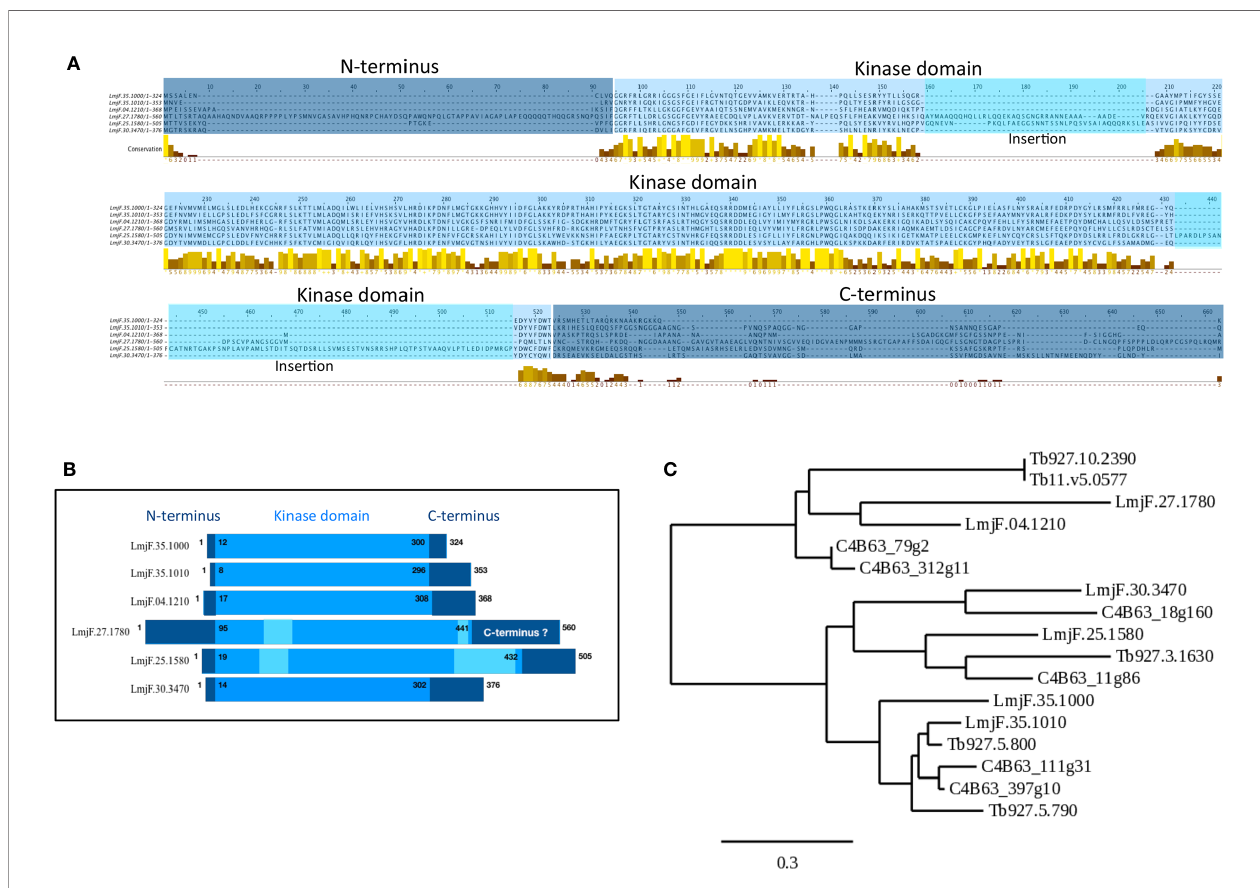
FIGURE 1 | Visualization of conserved CK1 regions and phylogenetic analysis. (A) Multiple sequence alignment of the Leishmania CK1s ( Table 1 ) was generated using the T-COFFEE Server (http://tcoffee.crg.cat (Notredame et al., 2000)). The dark blue corresponds to the N- and C-termini; the lighter blue corresponds to the kinase domain; and the lightest blue corresponds to insertions in the catalytic domain. The conserved amino acids were visualized by Jalview; the color code is as follows, low level of amino acid conservation (dark brown) to highly level of conservation (yellow) (https://www.jalview.org (Waterhouse et al., 2009)). (B) Schematic representation of the domain organisation of the different Leishmania CK1s, see A for the color code. (C) Phylogenetic tree of all the trypanosomatid CK1s described in the text (see Table 1 ) obtained using the http://www.phylogeny.fr server (Dereeper et al., 2008). The bar represents an evolutionary distance of 0,3%.